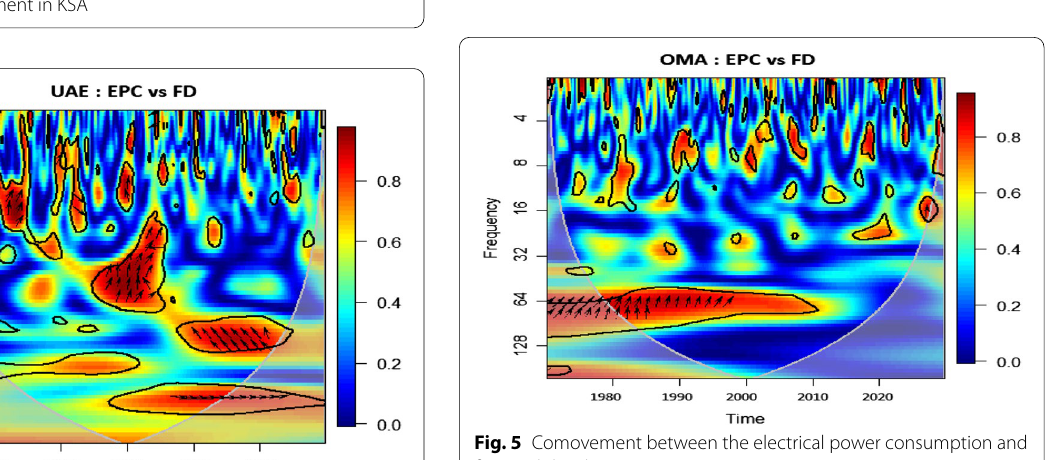
Fig. 2 Comovement between the electrical power consumption and